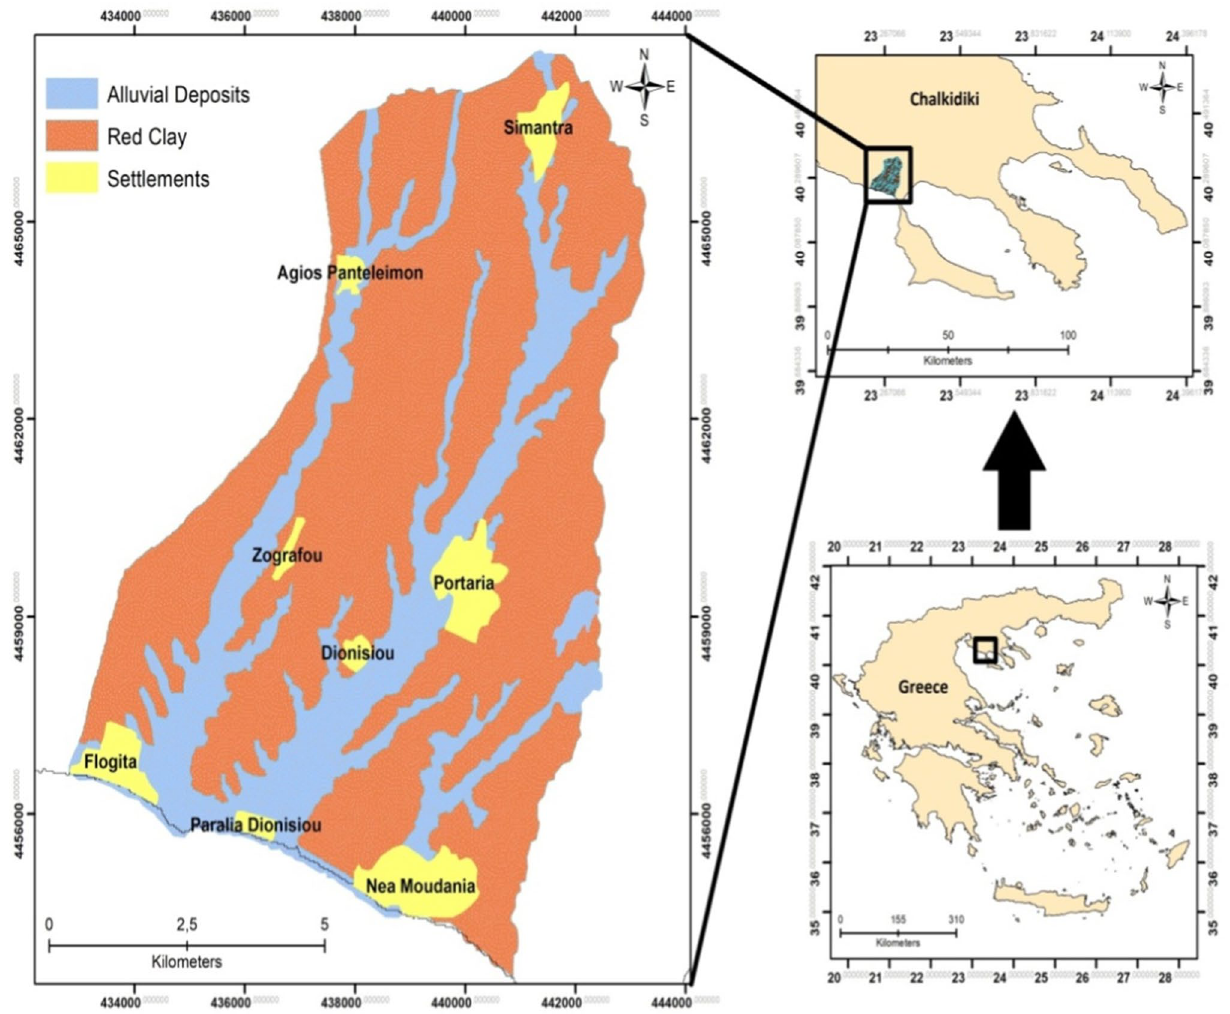
Fig. 1 Location and geological map of the study